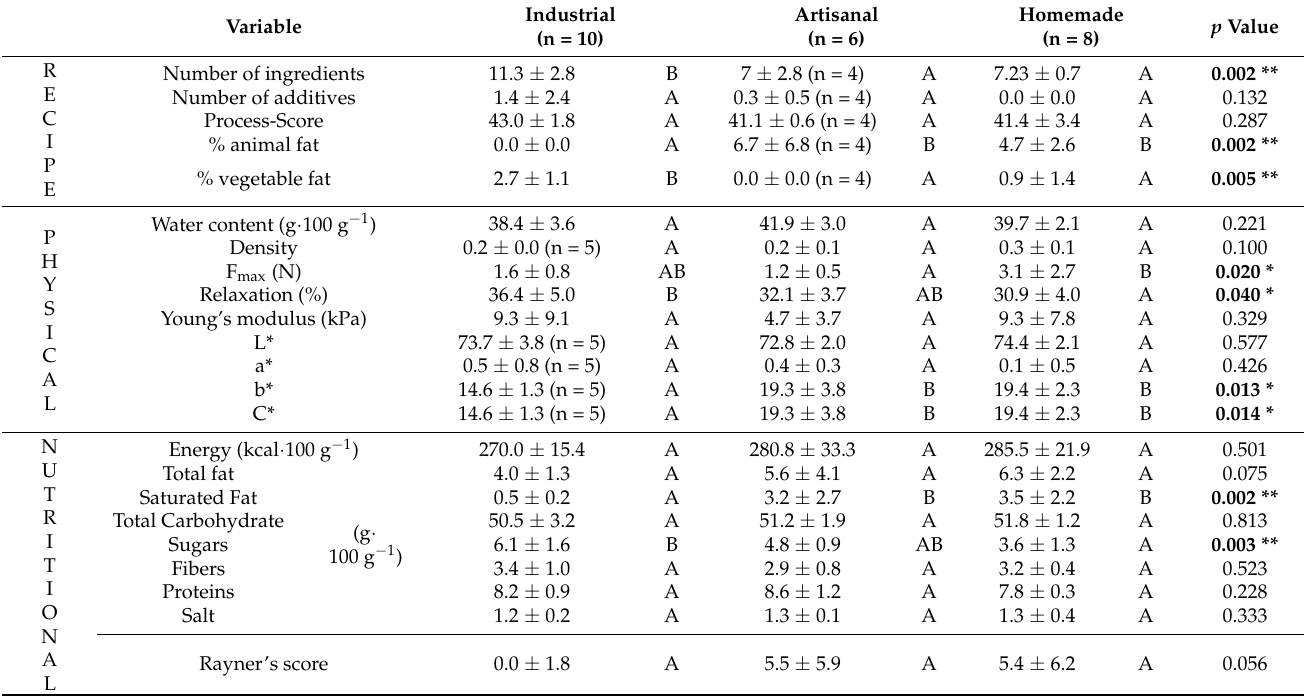
Table 2. Statistical comparison of the different tested variables (units in parentheses) among the three processing methods. Mean values ± standard deviation (n = values taken into account, if different from the group as a whole) are shown for each processing method, with the p value of an ANOVA or Kruskal–Wallis test. Statistical groups determined by post hoc test (Tukey or Conover-Iman, respectively) are indicated by letters. * for p ≤ 0.05, and ** for p ≤ 0.01, in bold when below the threshold of